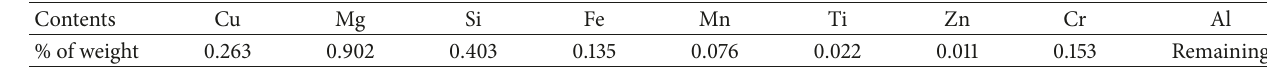
Table 2: Compositions of AA6061.